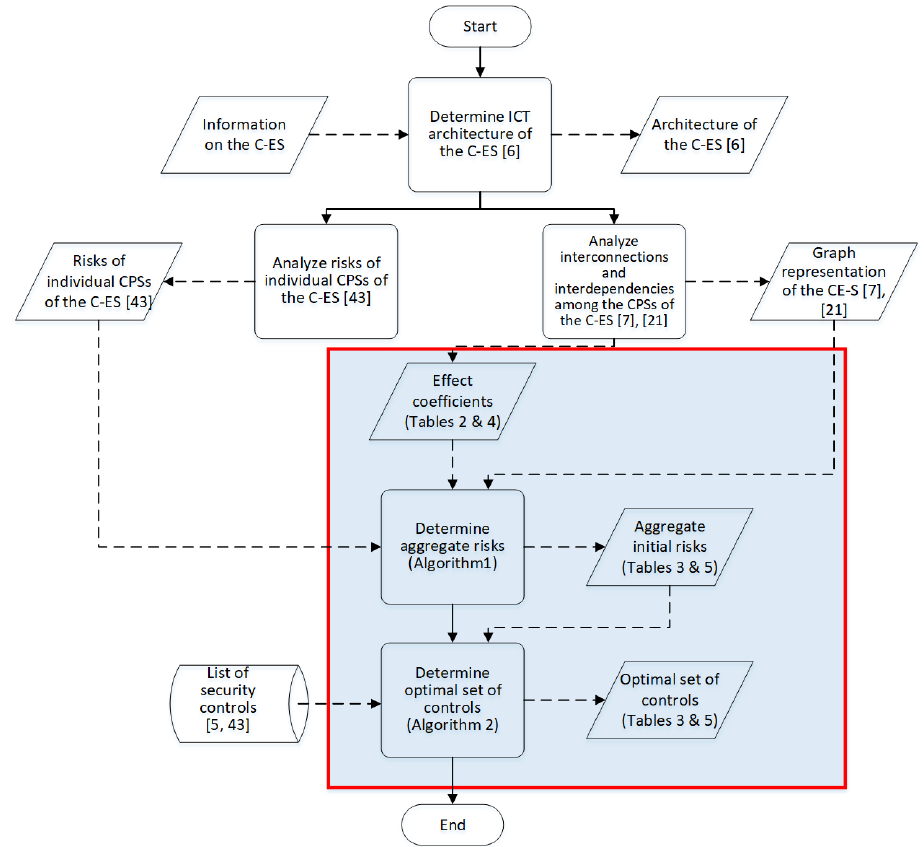
Figure 7. Overall